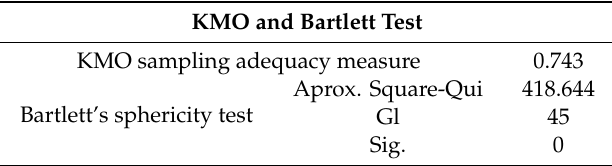
Table 4. Kaiser–Meyer–Olkin (KMO) and Bartlett sphericity